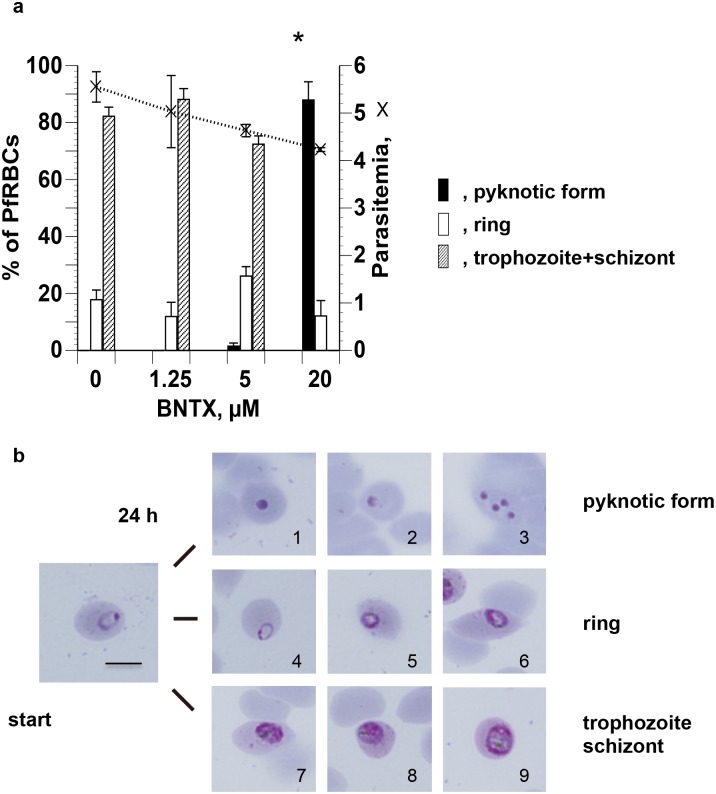
Effect of BNTX on the development and morphology of synchronized P. falciparum.(a) Parasites synchronized at the ring stage were cultured for 24 h in the presence of graded concentrations of BNTX. Each developmental stage and parasitemia (×) were counted after Giemsa staining. (b) PfRBCs showed pyknosis (1–3), arrested growth at the ring stage (4–6), and the normal development (7–9). Morphological changes were observed microscopically after culture of synchronous ring stages for 24 h in the presence of BNTX, following Giemsa staining. *Significant difference versus no BNTX. The scale bar depicts 5 μm.